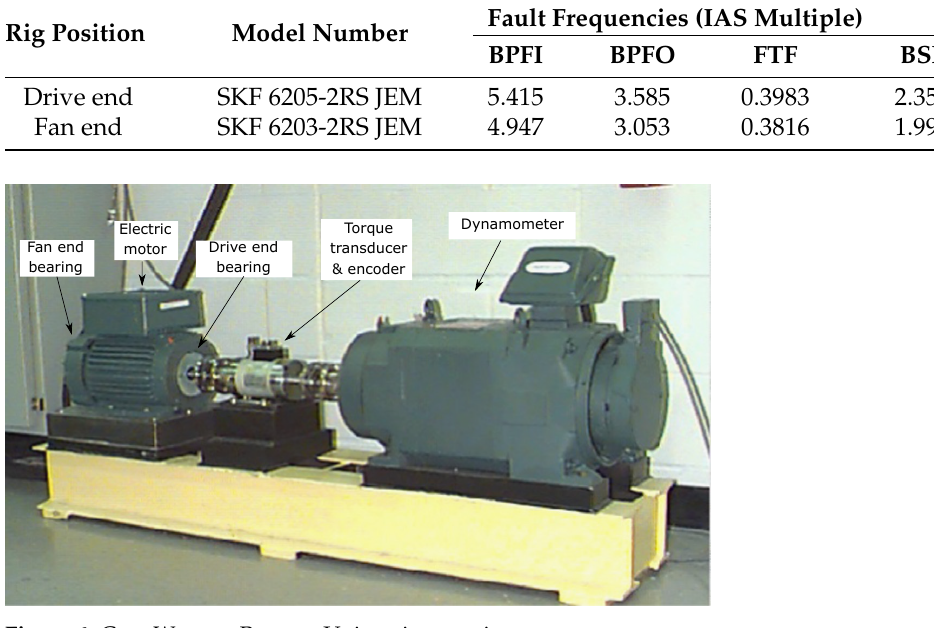
Figure 6. Case Western Reserve University test